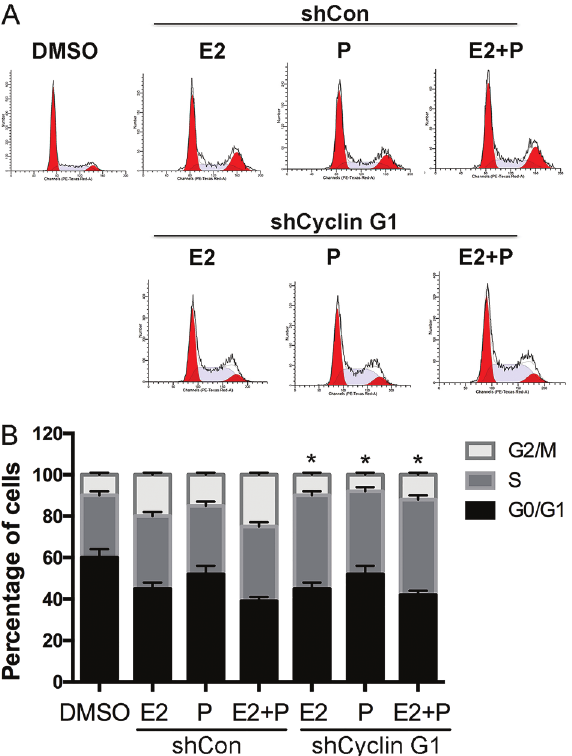
Figure 7. Knockdown of cyclin G1 (shCyclin G1) limits estradiol (E2)- and progesterone (P)-mediated cell accumulation in G2/M phase in MCF-7 cells. A , Cell cycle analysis. B , Percentage of cells in cell cycle phases with each treatment. Data are reported as means ± SD. *P o 0.05 vs shCon (Student ’ s t